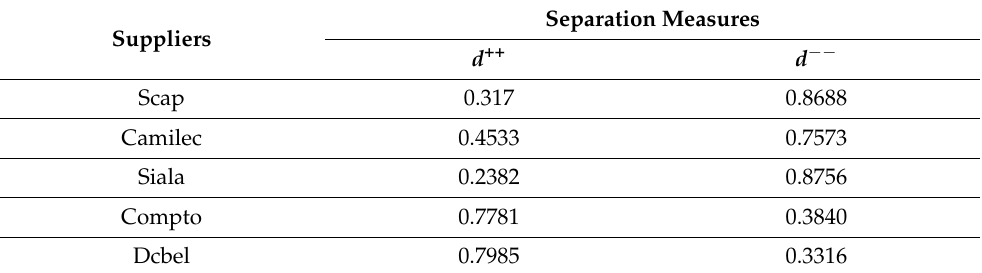
Table 7. The Weighted Normalized